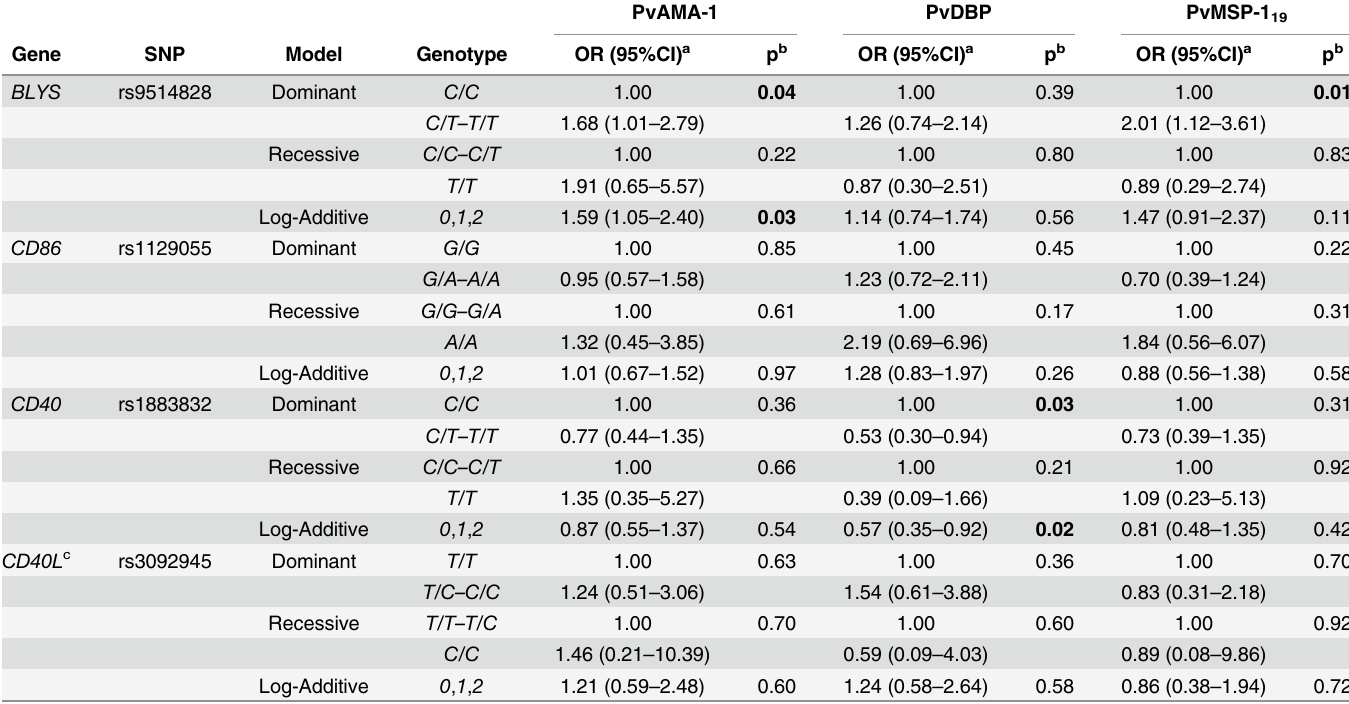
Table 2. Associations between Polymorphisms and Antibody Responses against Blood-Stage Proteins of P . vivax